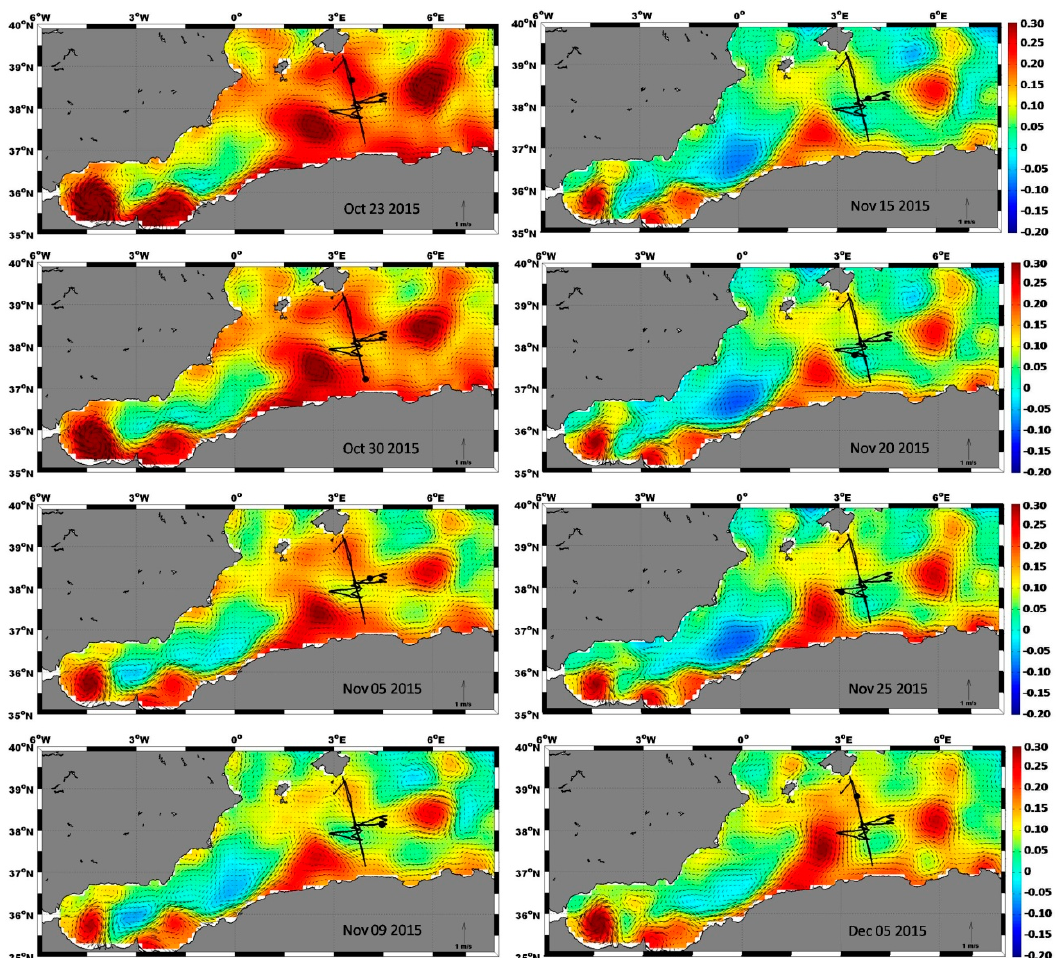
Figure 13. All-sat-merged AVISO ADT maps of the Alboran Sea and the Algerian Basin on eight representative dates of the ABACUS 2 survey. Glider track in black. Large black dots represent glider location on each date. Geostrophic currents are represented through black arrows. ADT in meters.